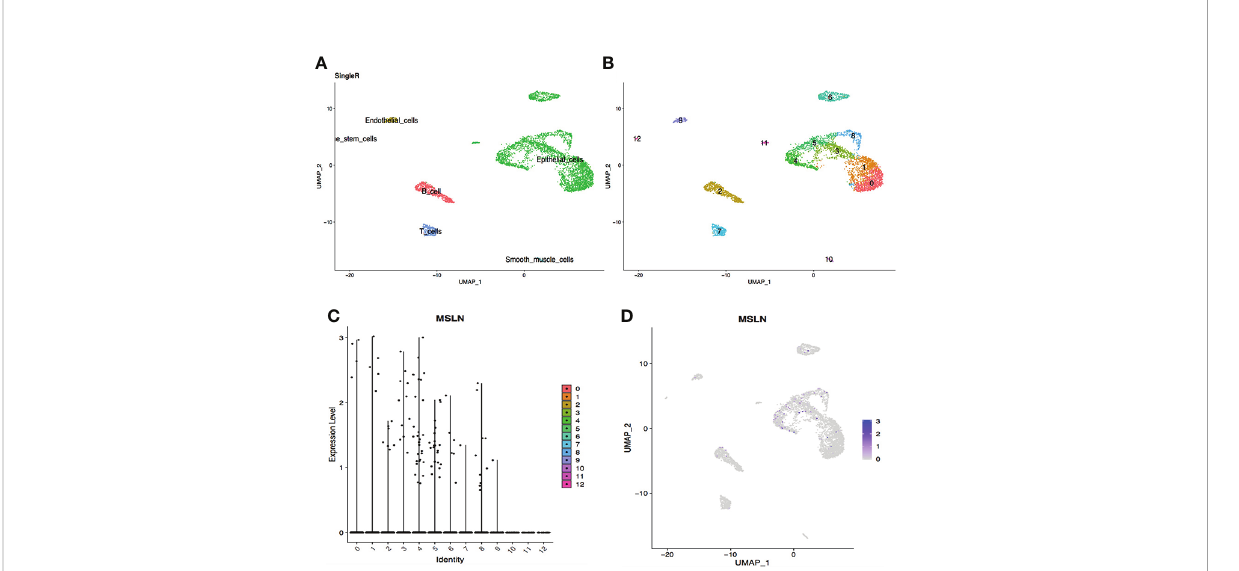
FIGURE 3 Analysis of scRNA-seq data from stomach cells showing high expression level of MSLN. (A) Cell types in the stomach according to SingleR. (B) Cells in the stomach were categorized into 13 different clusters, numbered 0 to 12. (C) Violin plot of MSLN expression distribution in these 13 different cell clusters. (D) MSLN expression distribution shown as a scatter plot.